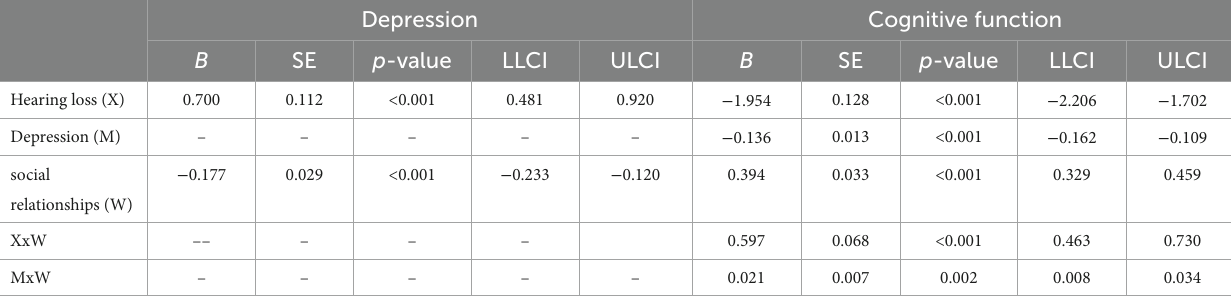
TABLE 5 Testing the moderated mediating effect of hearing loss on cognitive function by depression and social